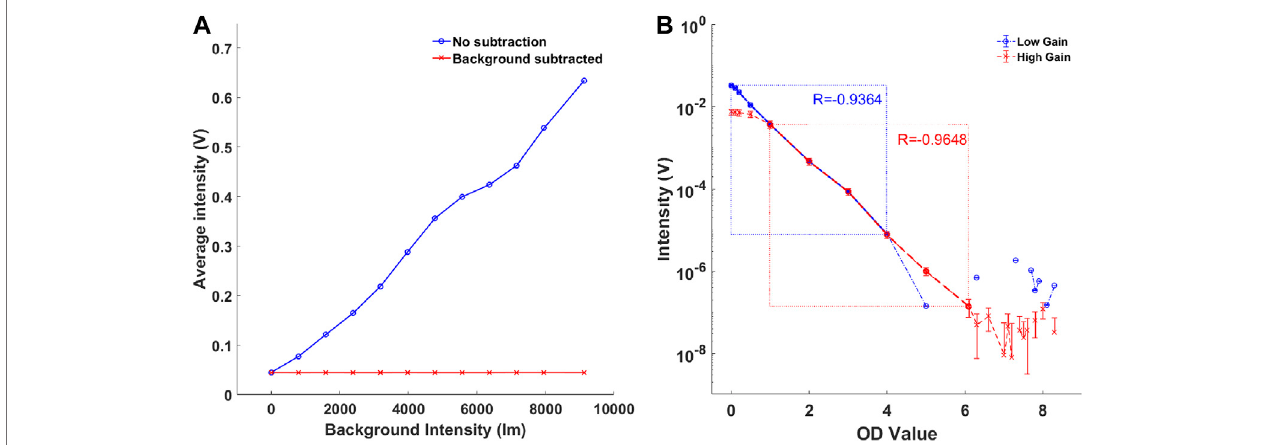
FIGURE 6 | (A) The stability of laser diodes over a period of 4.5 h. Note: channels 300, 340, and 590 are LEDs, and were not measured with the photodiode. (B) The stability of APDs over a period of 4.5 h. Note: the instability of laser diodes has been accounted for in the chart.